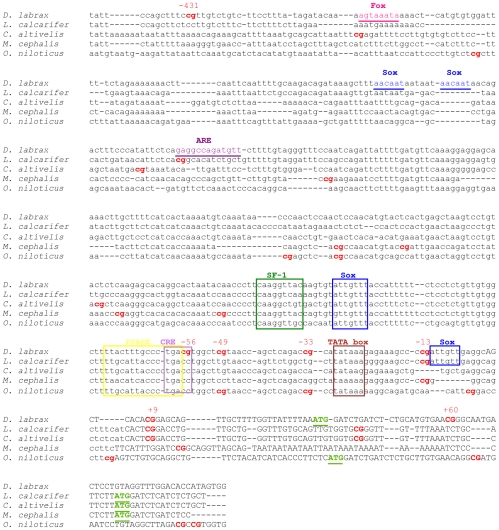
Alignment of the sea bass gonadal cyp19a promoter with that of other teleost species.Accession numbers: Dicentrarchus labrax, DQ177458; Lates calcarifer, AY686690; Cromileptes altivelis, AY686691; Mugil cephalus, AY859426; Oerochromis niloticus, AB089924. CpG dinucleotides are shown in bold. The numbers above D. labrax CpGs denote the position relative to the transcription start site. Putative binding sites for specific transcription factors were localized in D. labrax after Galay-Burgos et al.
[6] and are indicated by boxes when are conserved among species or by underlying if apply only to D. labrax. The open reading frame is depicted by upper case text and putative transcription start sites “ATG” are highlighted in bold and underlined.